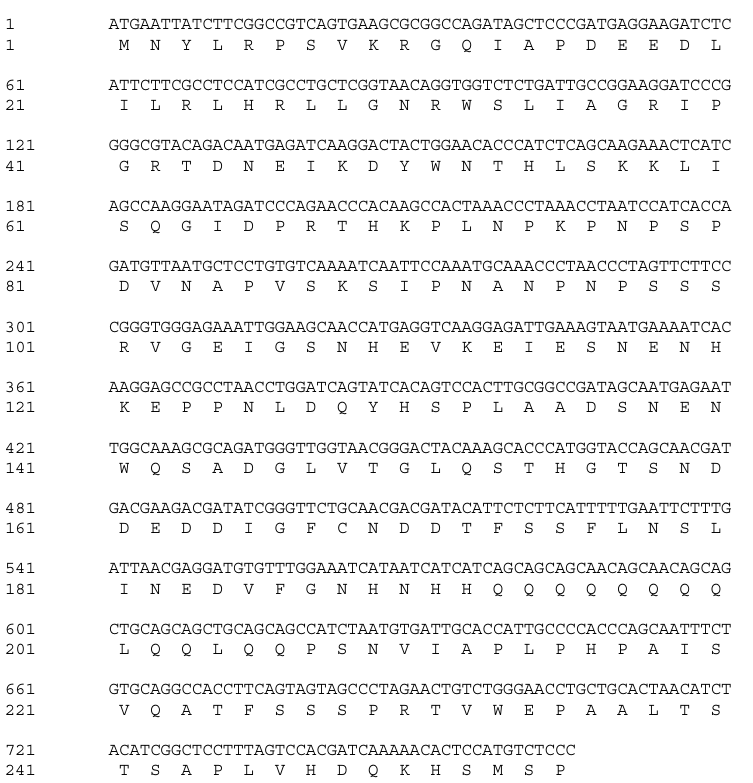
Figure 1. The complete cDNA sequence and amino acid sequence of the protein encoded by MybA1 (GenBank accession number: KJ513437).